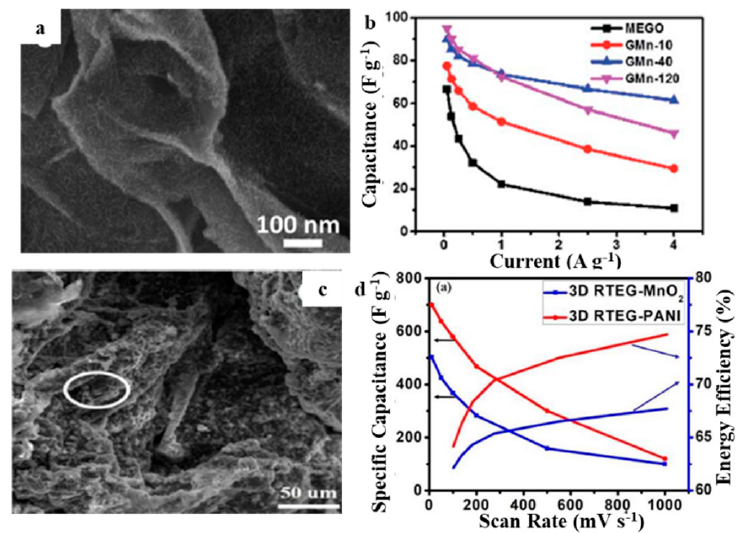
Figure 5. SEM of ( a ) MEGO–MnO 2 [51], ( c ) 3D RTEG–MnO 2 [52], the specific capacitance of ( b ) MEGO–MnO 2 [51], ( d ) 3D RTEG–MnO 2 and RTEG–PANI with various current densities [52]. Reprinted with permission from Reference [51]. Copyright 2016 RSC. Reprinted with permission from Reference [52]. Copyright 2019